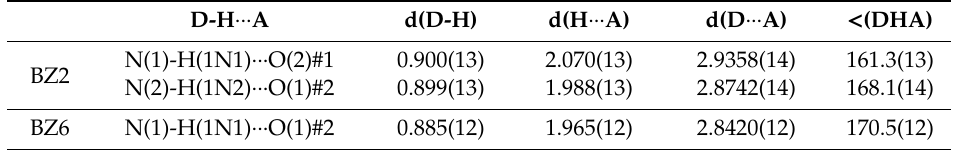
Table 2. Hydrogen bonds for BZ2 and BZ6 [Å and ◦